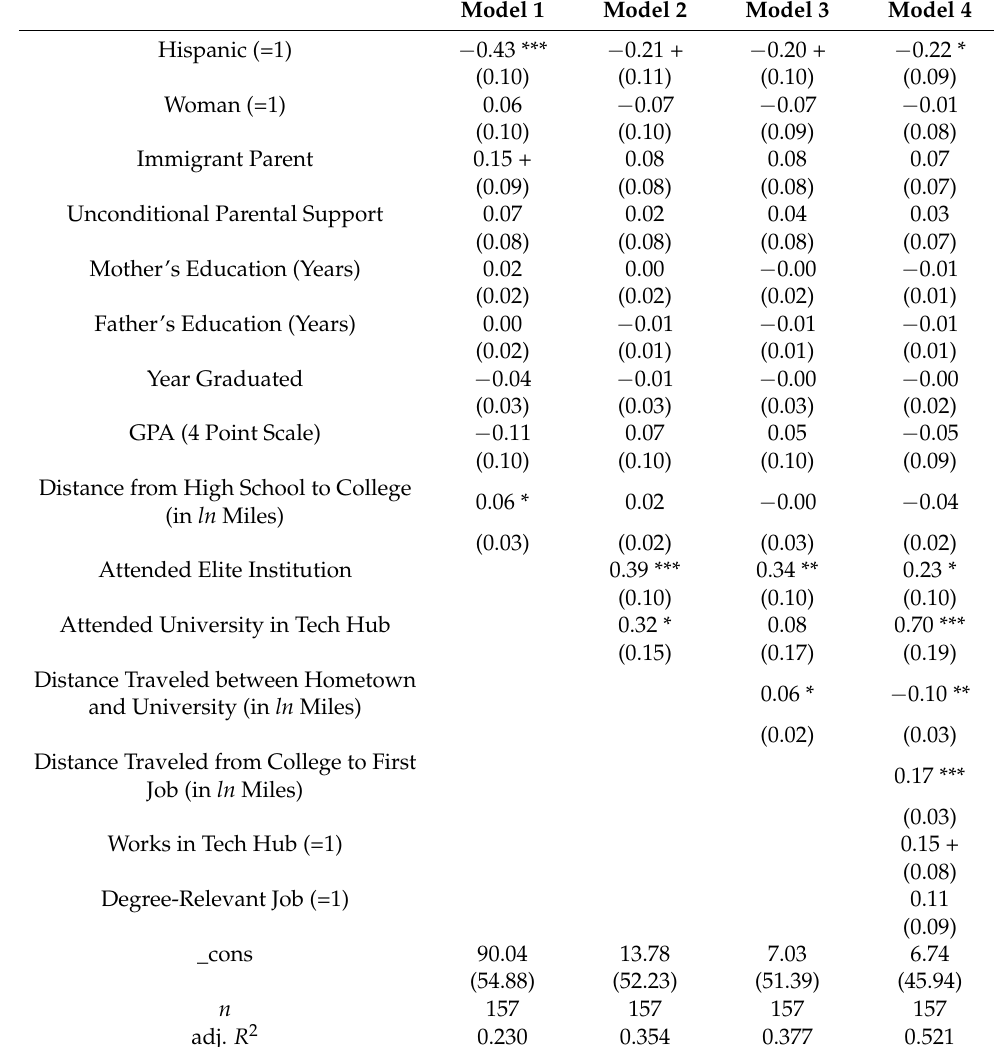
Table 5. Predictors for salary of CS degree recipients in Texas,